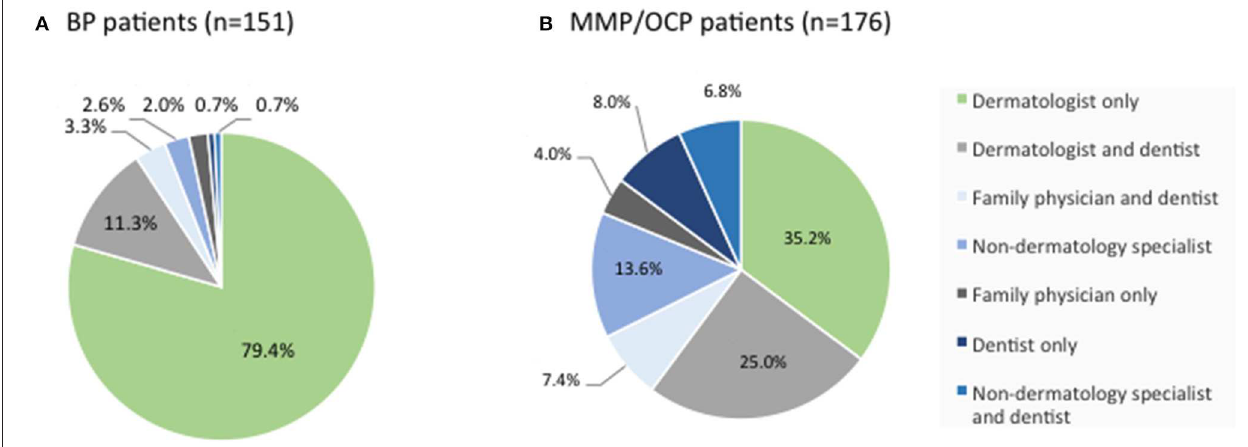
FIGURE 4 | Distribution of medical provider care. BP (A) and MMP (B) patients from the IPPF registry were analyzed in terms of medical provider care. Percentages list the type of provider or combination of providers consulted for the respective skin condition out of all patients reporting medical care.